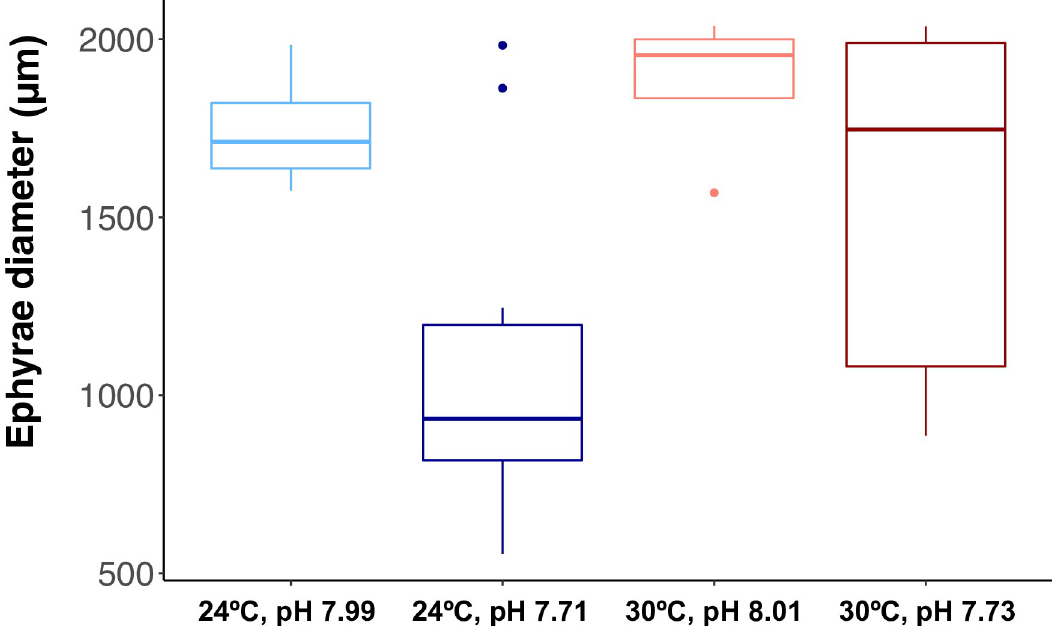
Fig 4. Diameter of ephyrae released under the different temperature (24˚C and 30˚C) and pH (ambient and future) treatments. Light blue for 24˚C and pH 7.99, dark blue for 24˚C and pH 7.71, light red for 30˚C and pH 8.01 and dark red for 30˚C and pH 7.73. Error bars represent standard deviation